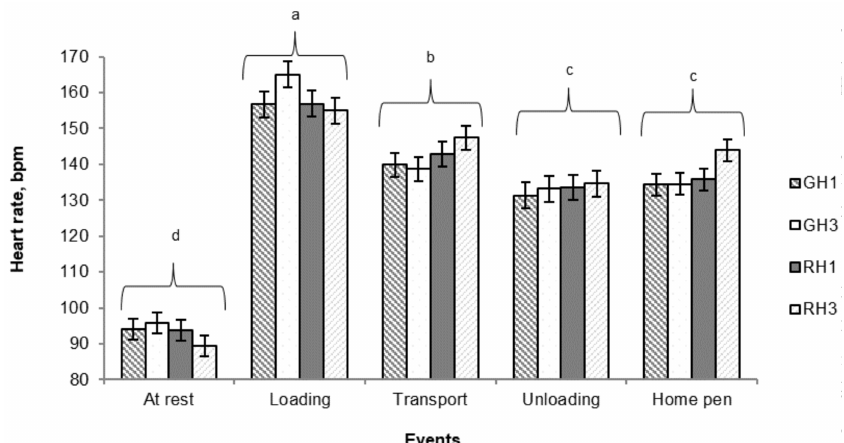
Figure 4. Least square means ( ± SEM) of heart rate variation measured at rest, during loading, during transport, during unloading and on the return to the home pen. Least square means without a common superscript di ff er (Tukey’s test; P < 0.001). GH1: One lap of the handling course with gentle handling;